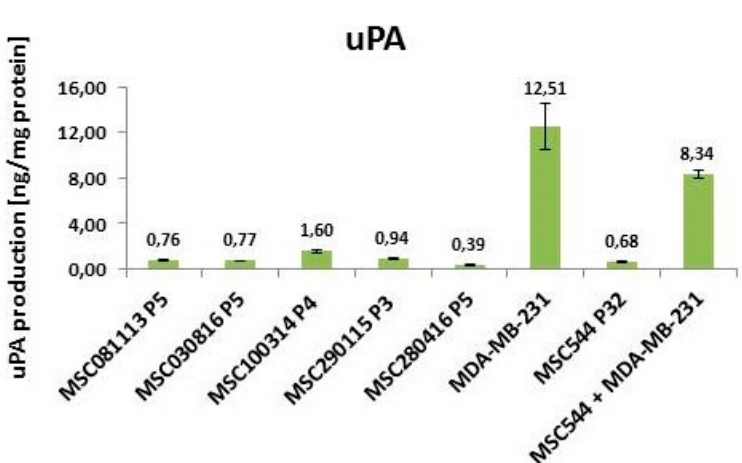
Figure 3. Quantification of urokinase plasminogen activator (uPA) in different MSC cultures and MDA-MB-231 breast cancer cells. Intracellular amounts of uPA were quantified in five different primary MSC cultures at different passages and compared with MSC544 P32. Moreover, the levels of uPA in MSC544 were compared to MDA-MB-231 breast cancer cells and to a 3D spheroid formed after long-term co-culture (62 days) between MSC544 GFP and MDA-MB-231 cherry . Data represent the mean + s.d. ( n = 4).